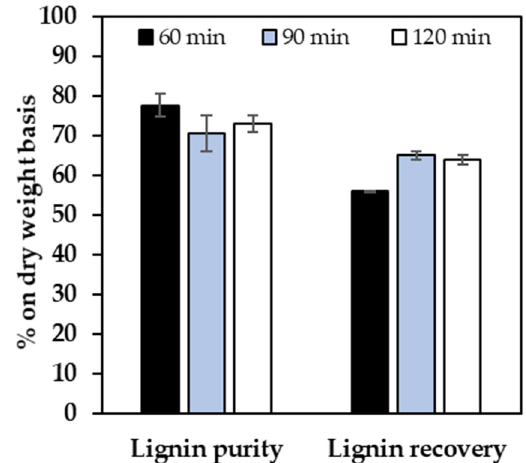
Figure 4. E ff ect of retention time at S / L ratio of 1:10 on lignin purity ( p -value = 0.118) and recovery Figure 4. Effect of retention time at S/L ratio of 1:10 on lignin purity ( p- value = 0.118) and recovery ( p- 277 ( p -value = 0.002). Error bars represent ± 2 × the standard deviation. value = 0.002). Error bars represent ± 2× the standard deviation. 278